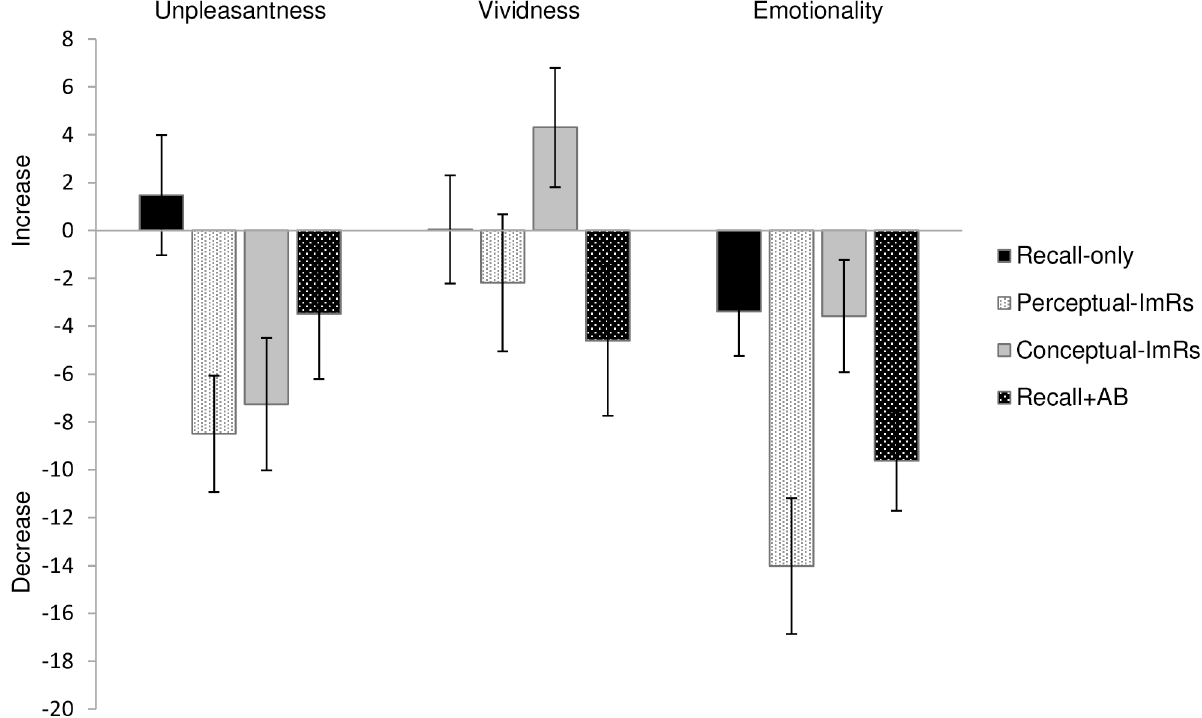
Fig 1. Changes in unpleasantness, vividness, and emotionality scores for the aversive autobiographical memory per condition (in mm; post-measurement – pre-measurement; positive scores indicate increases). Bars represent SEM. ImRs = Imagery rescripting, AB = Attentional